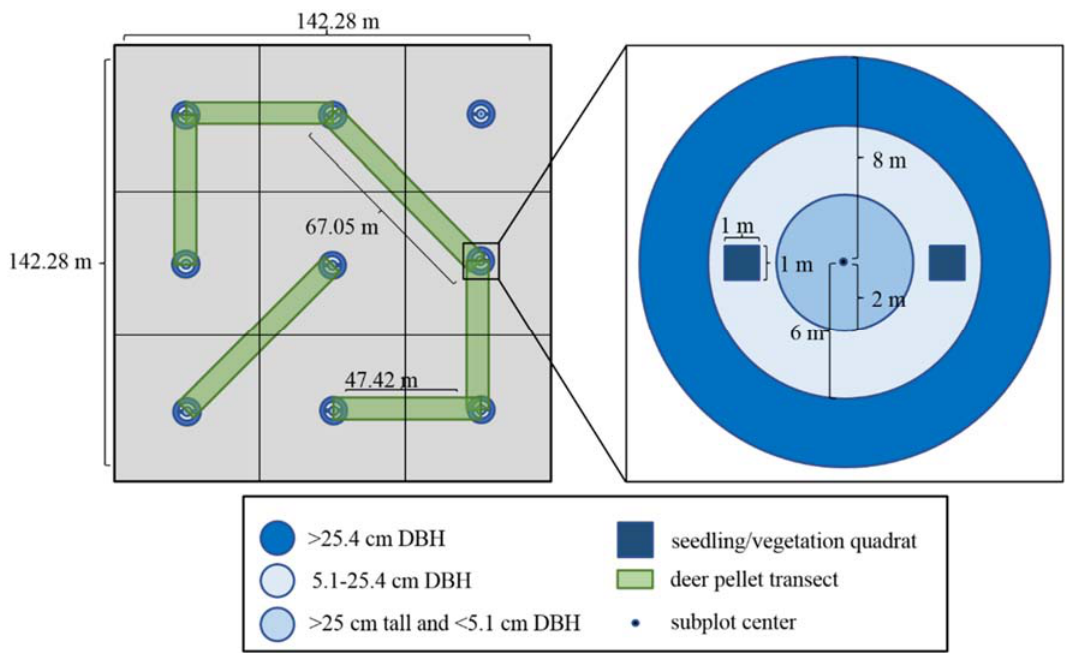
Figure 1. Plot design for vegetation measurements and deer pellet transect layout. DBH = diameter at breast height (137 cm).